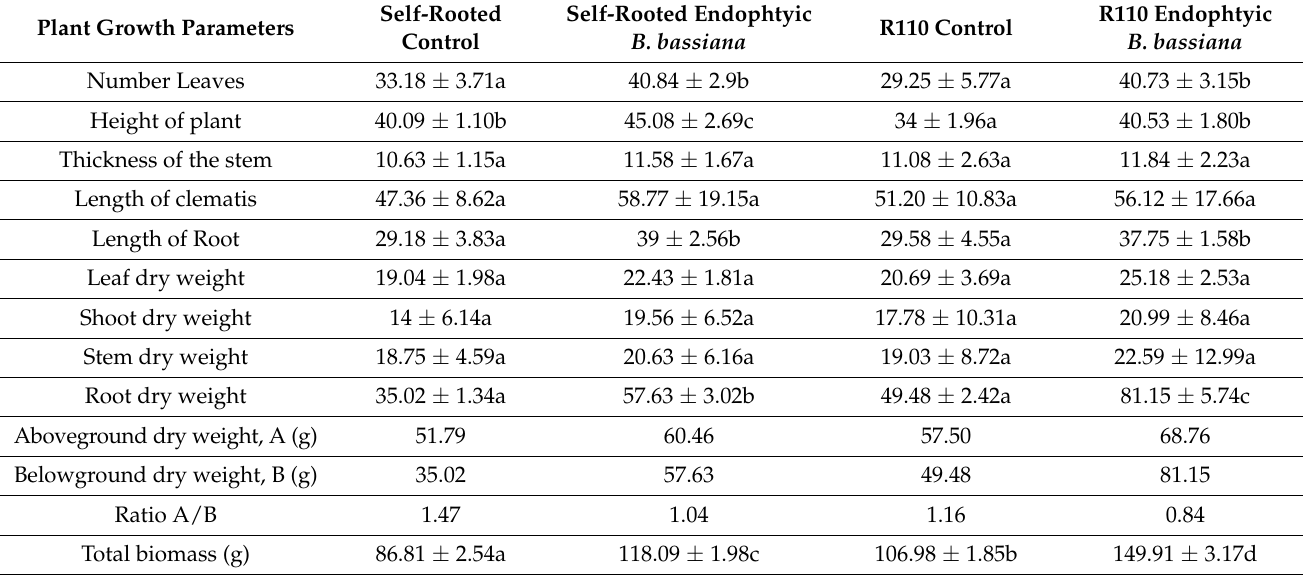
Table 2. Mean ( ± sd; n = 50) plant growth parameters of endophyte-free V. vinifera plants (control) and plants infested with B. bassiana . Means of the same row followed by the same letter are not significantly different ( p < 0.05).